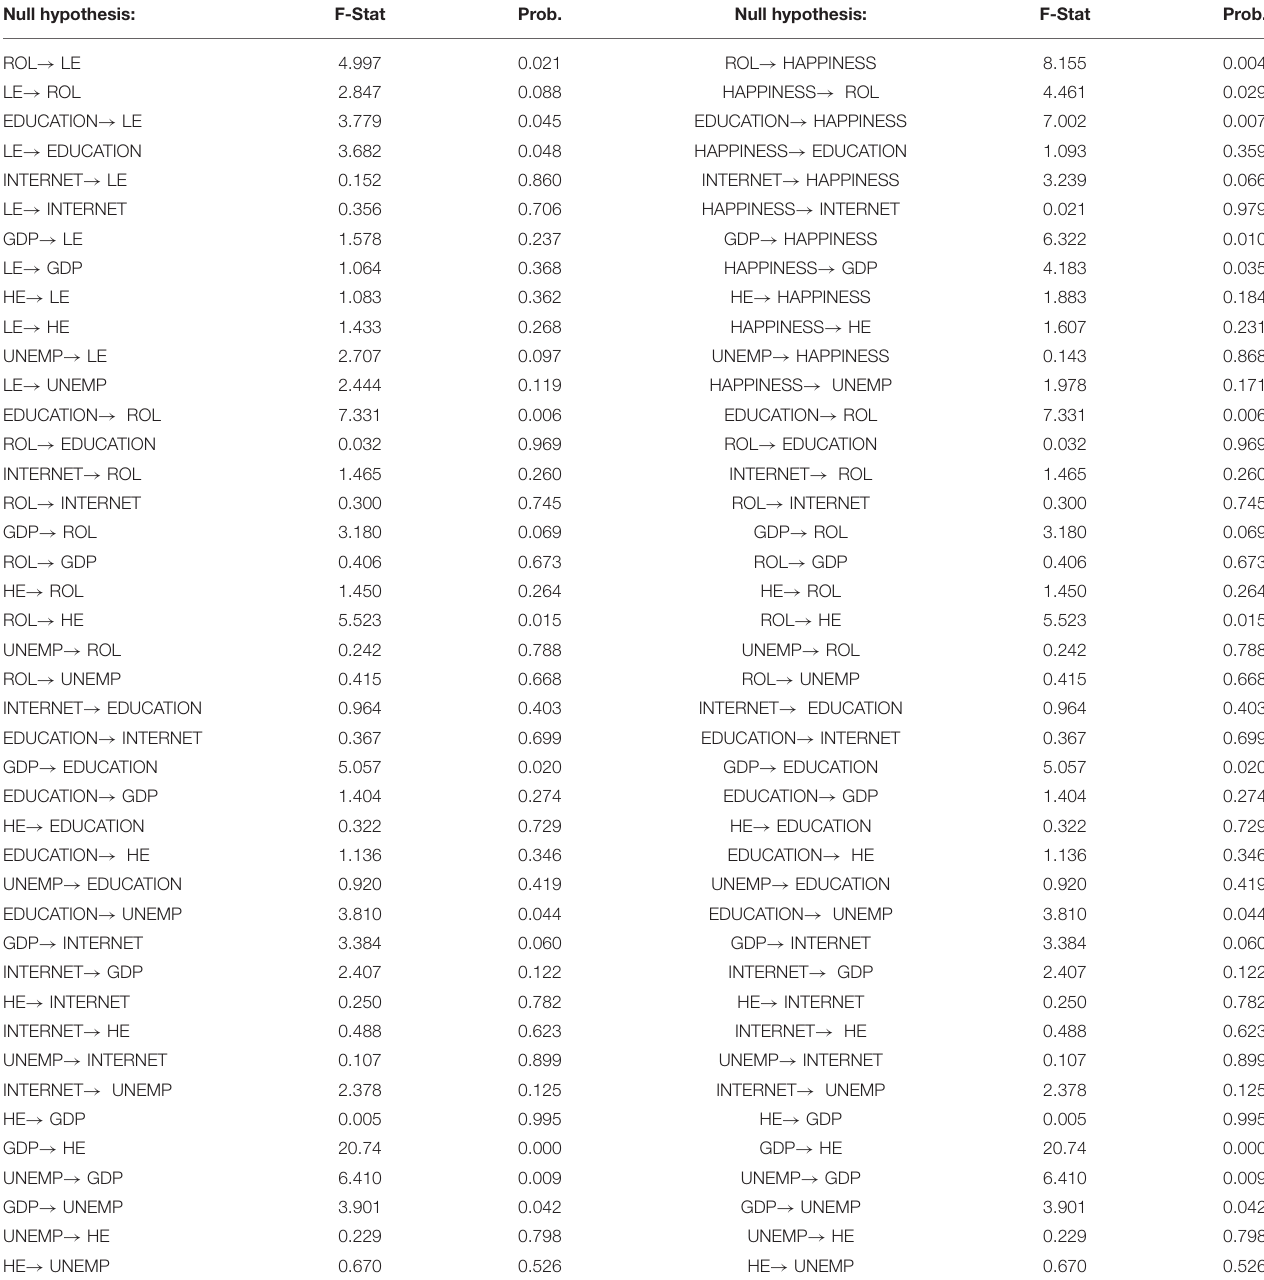
TABLE 4 | Results of causality test in